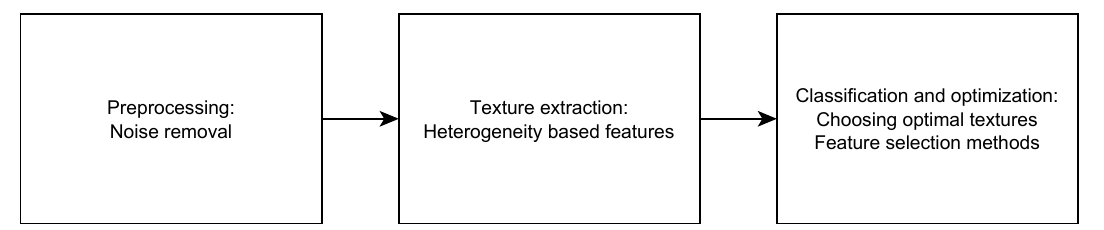
Figure 22. Heterogeneity-survival analysis pipeline (courtesy of D. Vrazhnov).